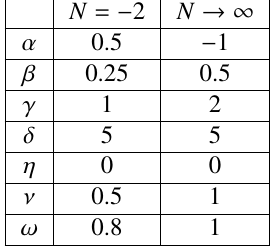
Table 3. Exact critical exponents for O ( N )-symmetric ϕ 4 field theory in 3 d for N = − 2 and N = ∞ N = −